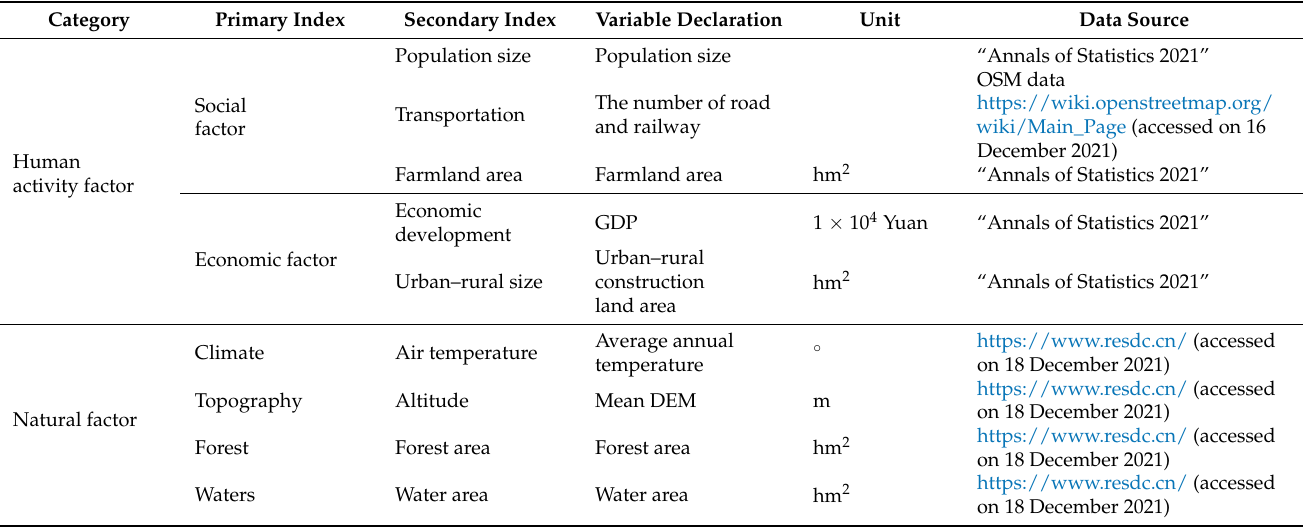
Table 1. Influence factors of ICH distribution.